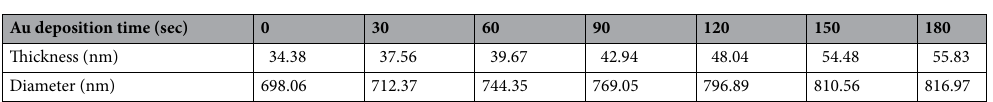
Au deposition time (sec)